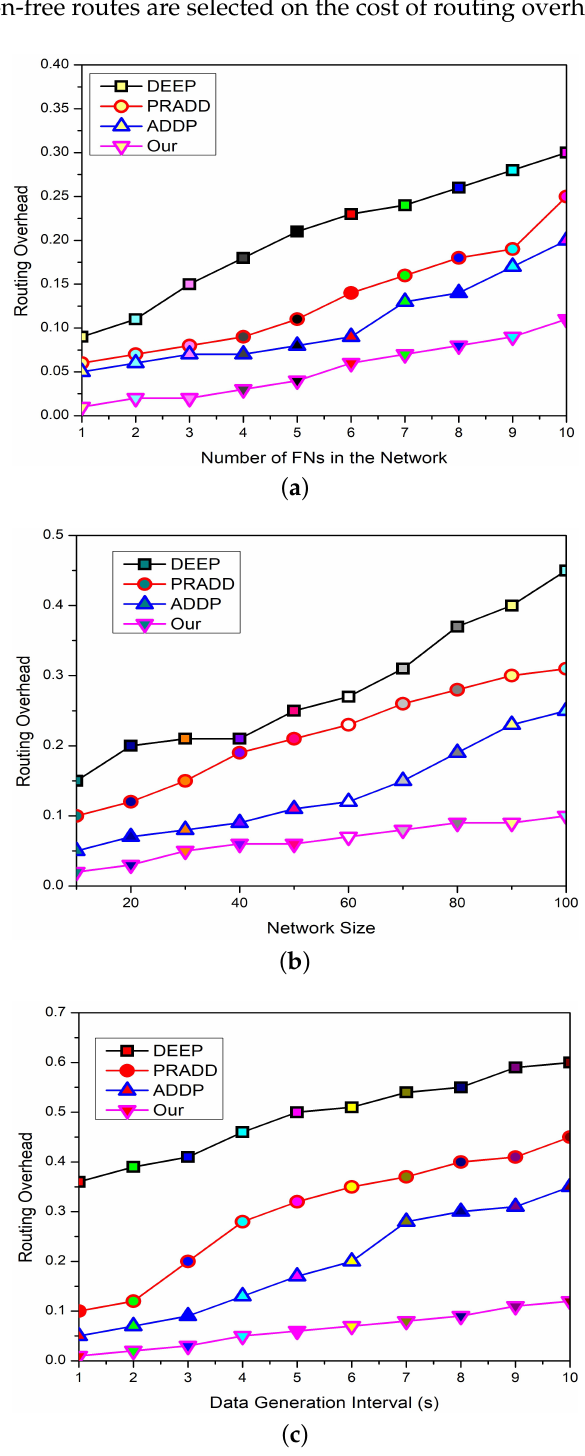
Figure 10. The comparison of routing overhead with number of field nodes, network size, and data generation